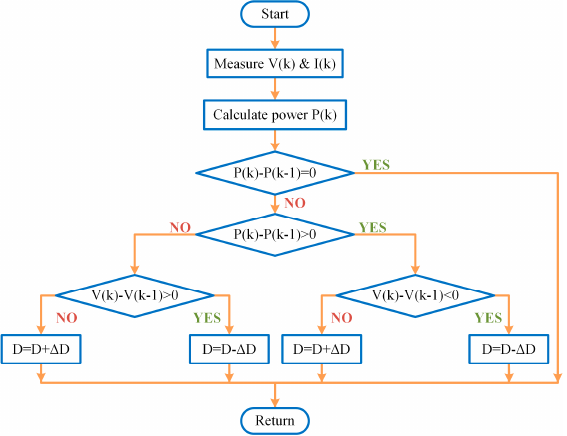
Figure 4. Perturb and Observe (P&O) algorithm with MPPT flowchart.